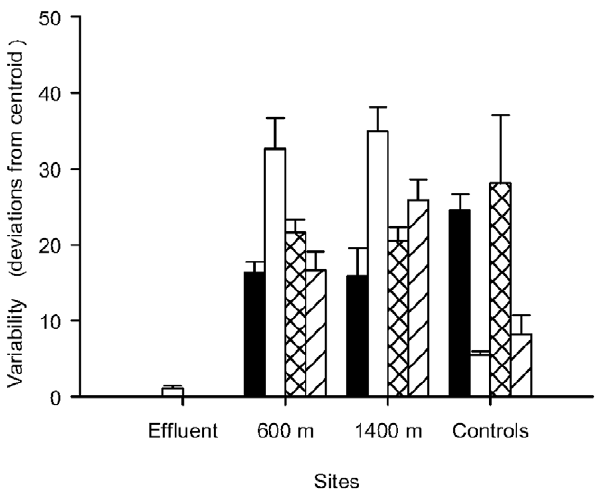
Figure 6. Variability in the assemblages within the Effluent site, the sites 600 m and 1400 m away from the effluent and within the controls. The deviations from the centroids in each site were calculated within each time. Black bars=T1; White bars=T2; Crossed bars=T3; Striped bars=T4. n =4 at the Effuent and 8 at the other sites; Note that in Time 3 and 4, only one control site (C2) was analyzed due to losses of replicates.